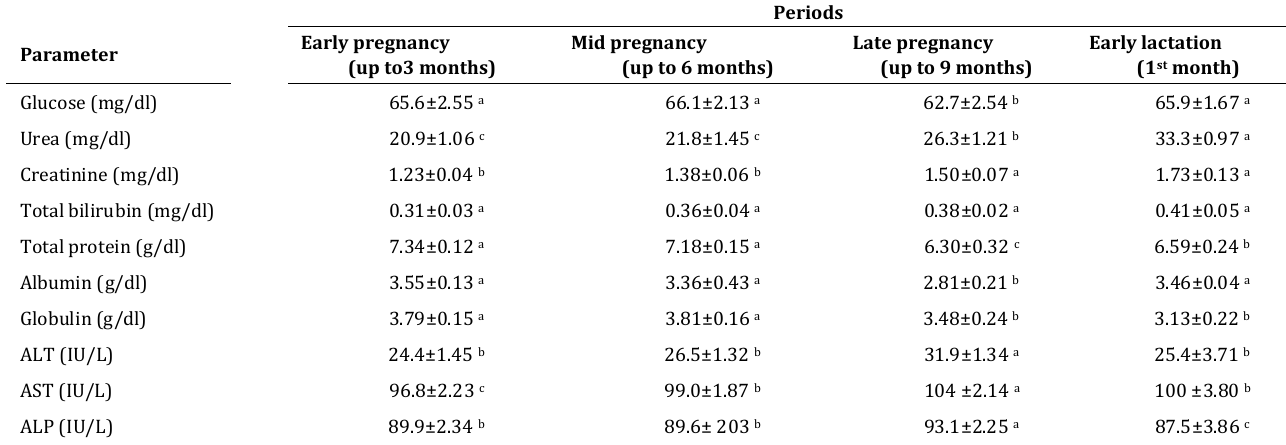
Table 3. Biochemical examination parameters through pregnancy stages and early lactation 1